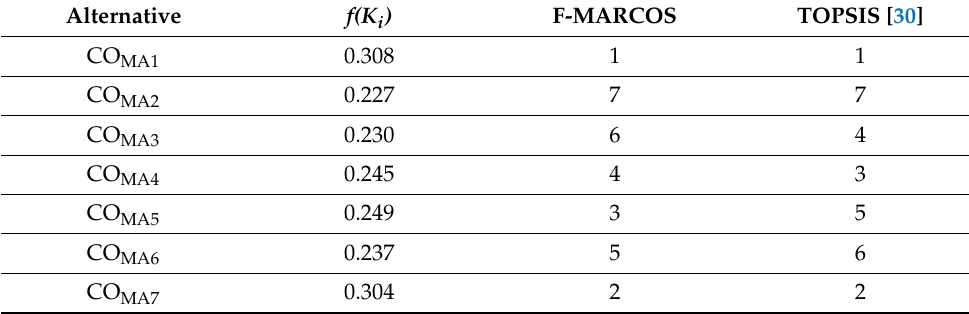
Table 17. Final preference value and ranking of the coating